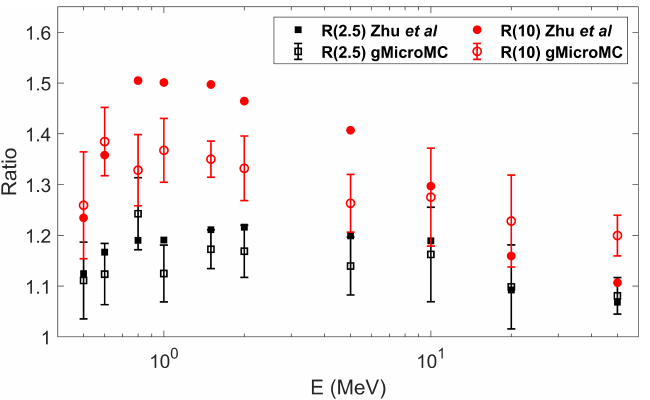
Figure 7. The relative DSB yields at different chemical stage durations t c and different proton ( t c = t ) energies with R ( t ) = DSB . The data from gMicroMC simulation were compared to that from DSB ( t c = 1 ns ) Zhu et al.’s work [42].